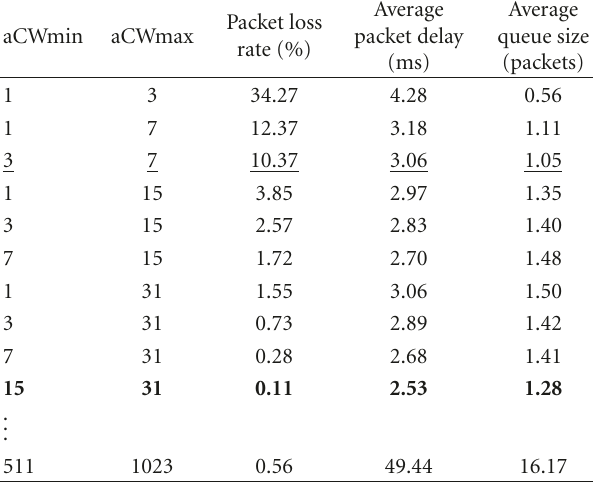
Table 4: E ff ects of varying aCWmin, aCWmax on the RT tra ffi c, for 20 RT stations—MSP = 5ms.